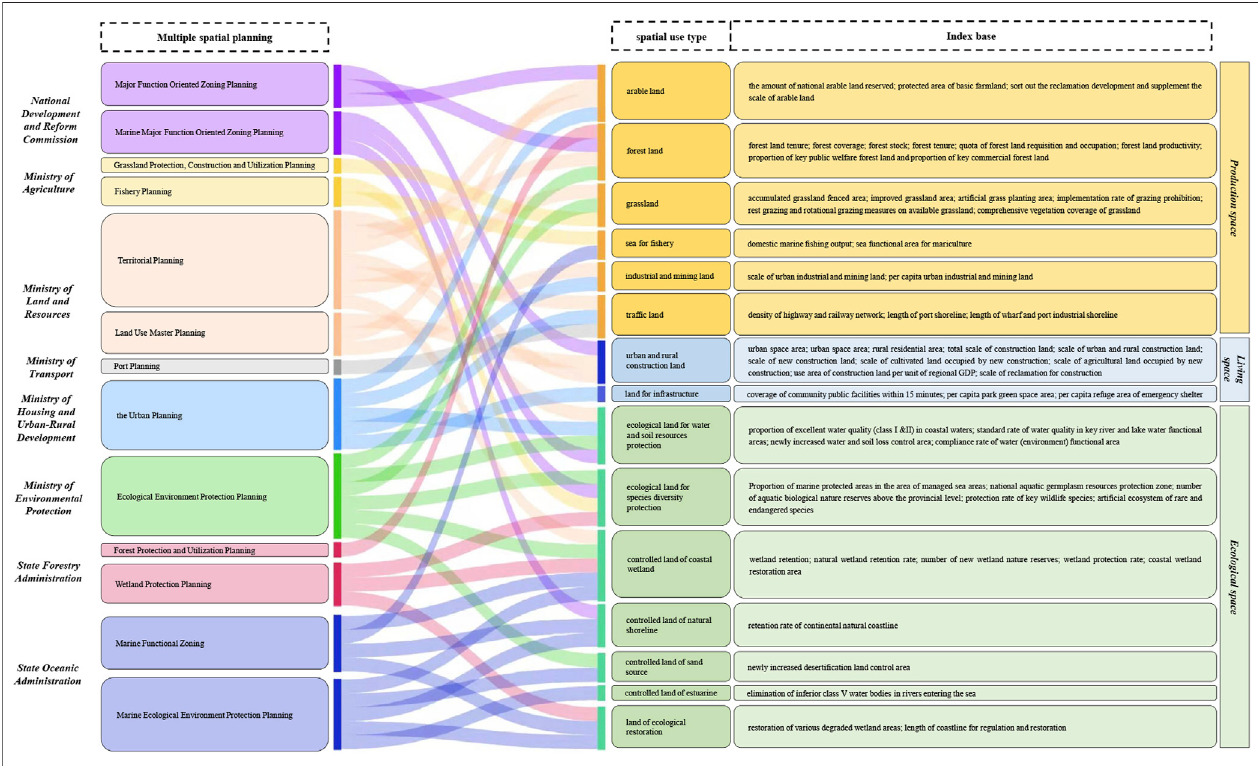
FIGURE5| Theindexsystemofspatialplanningisconnectedwithproduction-living-ecologicalspaces.Notesfor Figure5 :(1)weusedifferentcolorstorepresent the government departments of spatial planning in the column of “ multiple spatial planning ” ; (2) three colors are used to distinguish the “ production, ecology, and living space ” and its elements on the right side; (3) the lines indicates the fl ow direction of the existing spatial planning index system.